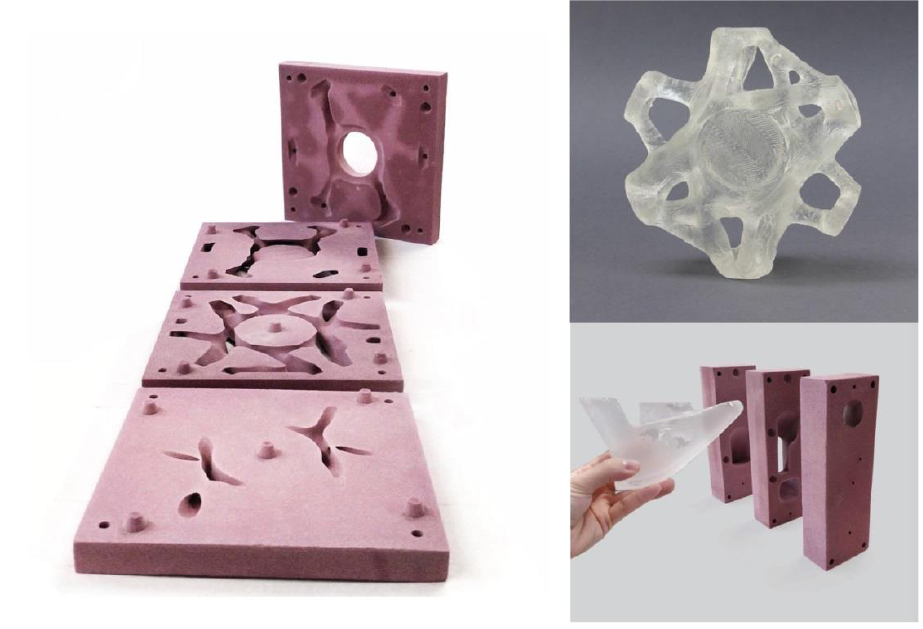
Fig. 11 3D-printed sand moulds produced by ExOne and the resulting cast glass components for a topologically optimized cast glass grid-shell node by (Damen 2019) (left and top right) and for a structurally optimized cast glass column by (Bhatia 2019) (bottom